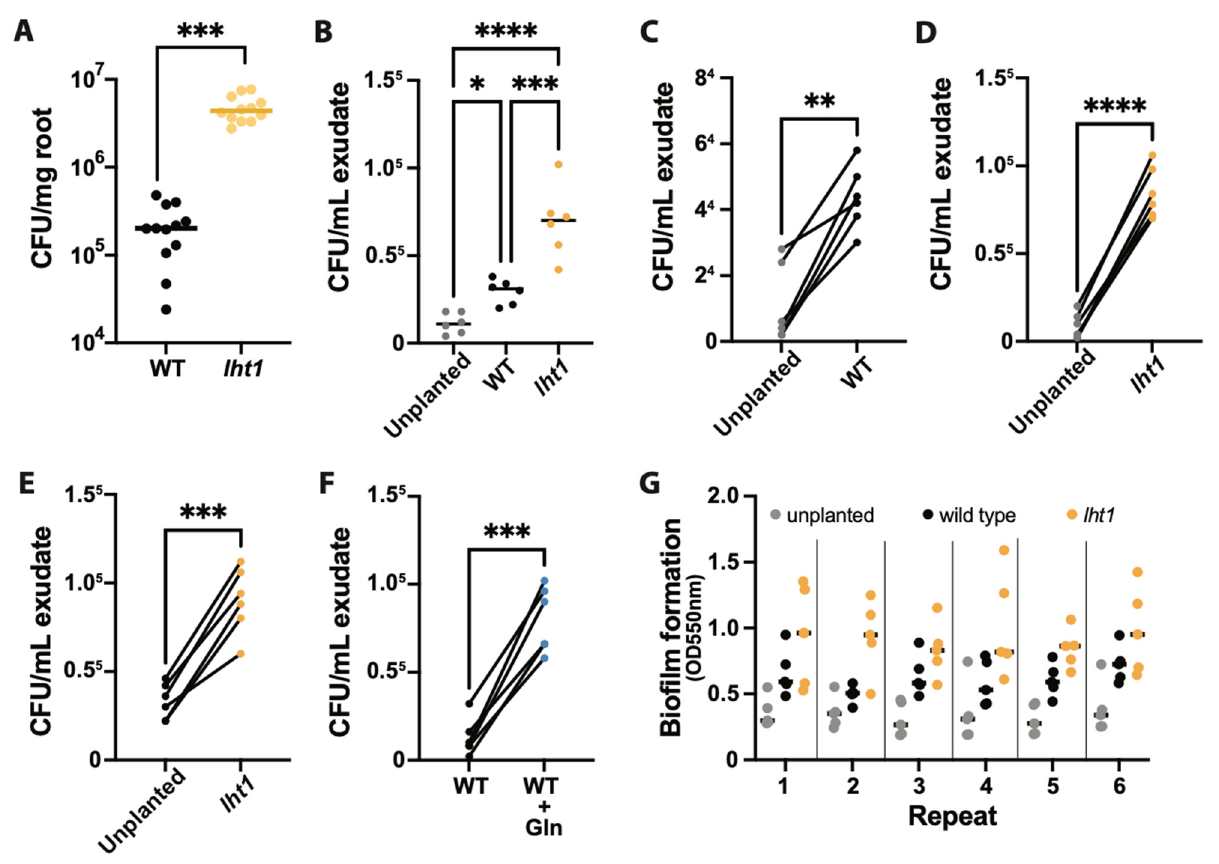
Figure 3. Ps WCS417r more effectively colonizes lht1 than wild-type roots. Across all panels in this figure, data are from at least 5–6 independent biological replicates. In each biological replicate, at least 5 seedlings/plants or their products (e.g., exudates) were analyzed. Each dot represents the median of 5 seedlings, 5 independently collected exudates, or 3 chemotaxis syringes per condition. In panels ( A , B ) the median of all biological replicates is shown as a bar. A two-sided Student’s t -test was performed for statistical comparison of two means or a Welch’s t -test for two means with unequal variances. For comparison of more than two means, a one-way ANOVA followed by Tukey’s posthoc test or a Kruskal–Wallis test for unequal variances followed by Dunn’s posthoc test was performed. The p -values are represented as * ≤ 0.05, ** ≤ 0.01, *** ≤ 0.005, and **** ≤ 0.001. Further experimental and analysis details are described in Section 5. ( A ) Loss of LHT1 promotes root colonization by Ps WCS417r. The 1X MS-wetted 3MM paper in which 6 seedlings were growing was inoculated with Ps WCS417r at OD 600nm = 0.00002. Seventy-two hours later, the roots were harvested, weighed, and ground; platting of serial dilution was used to assess colony-forming units (CFU) on LB agar